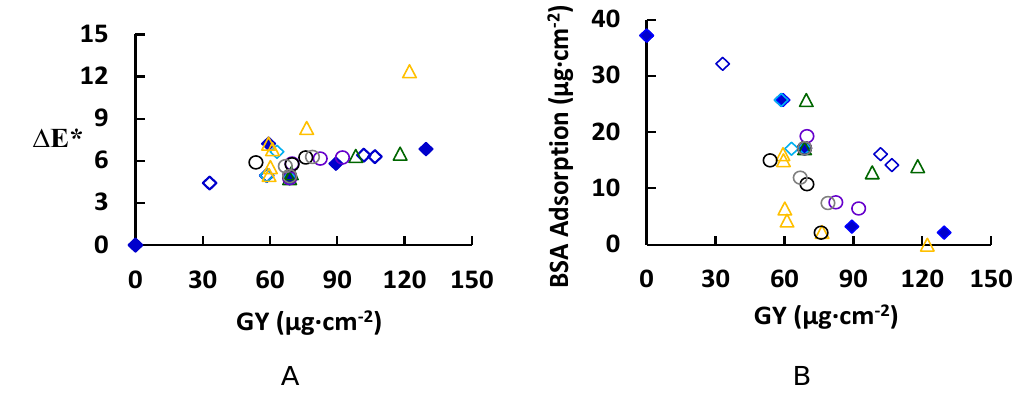
Figure 4. Membrane color change (∆ E *) ( A ) and BSA adsorption (total adsorption equals reversible + irreversible adsorbed protein) ( B ) with grafting yield (GY); the common reaction condition is 4.8 mM ferulic acid, 0.5 U·mL −1 laccase, 2 h modification time, 25 °C, pH 5, and 0.1 M sodium acetate buffer. The following parameters were studied: modification time (0.5, 2, 8, and 24 h) with 0.6 mM ferulic acid, and 4.8 mM ferulic acid, ferulic acid concentration (0.6, 1.2, and 4.8 mM) at 8 h modification time, reaction temperature (25, 35, 45, 55, 65 and 75 °C) at 0.5 h modification time, reaction pH (4, 5, 6, and 7), enzyme concentration (0.25, 0.5, 0.75, and 1 U·mL −1 ), buffer type (sodium citrate, citrate phosphate, sodium acetate, and phosphate), buffer strength (0.05, 0.1, and 0.5 M). Typical errors: ± 0.2 for membrane color change (∆ E *) and ± 0.3 µg∙cm −2 for BSA adsorption.